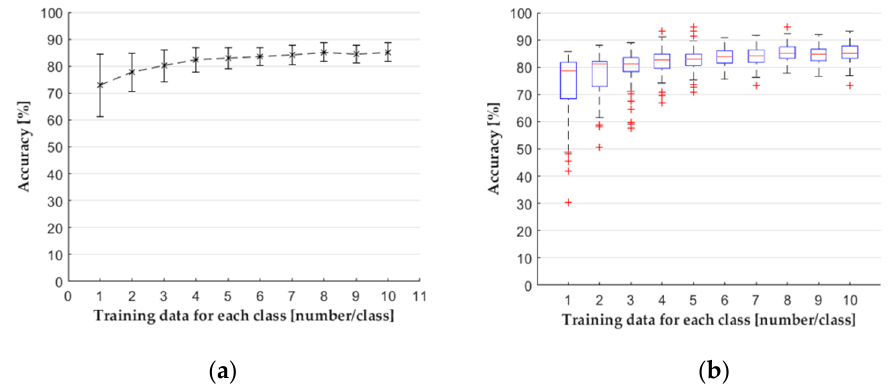
Figure 7. The performance of the kNN classifier when all features were used (CD) showed with ( a ) mean and standard deviation; ( b ) boxplot. ( a ) mean and standard deviation; ( b )